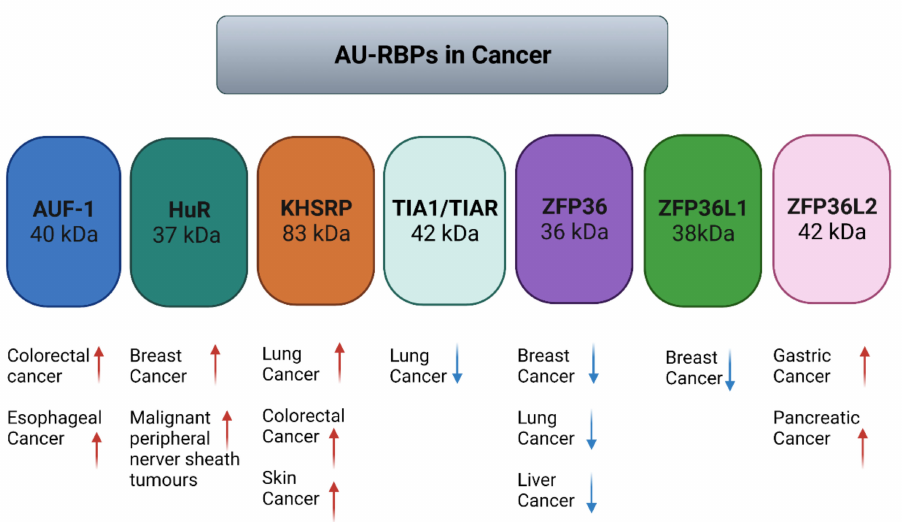
Figure 6. AU-RBPs are aberrantly expressed in various kinds of cancer, where AUF1, HuR, KHSRP and ZFP36L2 are found to be mostly upregulated and TIA1, ZFP36 and ZFP36L1 are found to be downregulated in breast, lung and liver